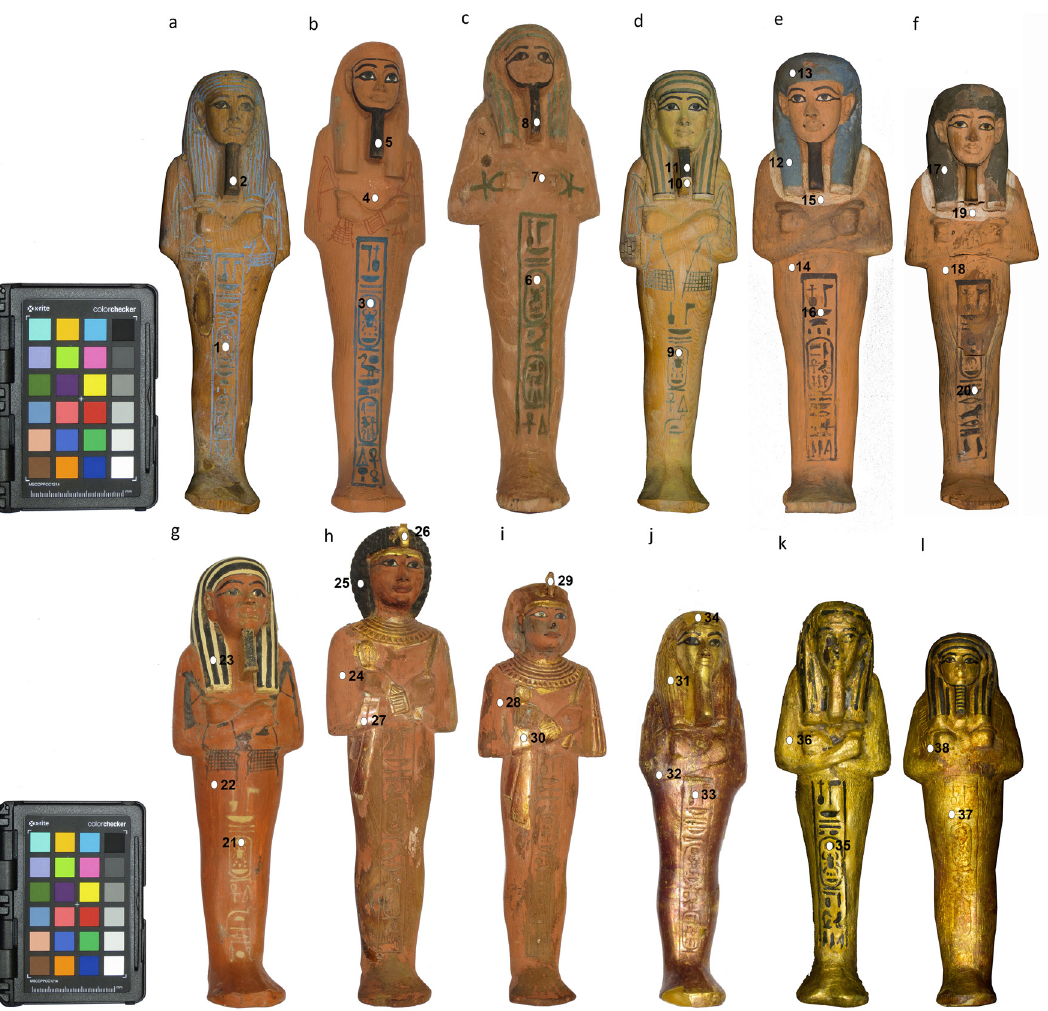
Figure 1: The selected shawabtis from King Tutankhamun collection as numbered in Table 1, and the spots marking the locations listed in Table 3 from where analysis by single - spot spectroscopic techniques were performed ( indicated by English numbers )